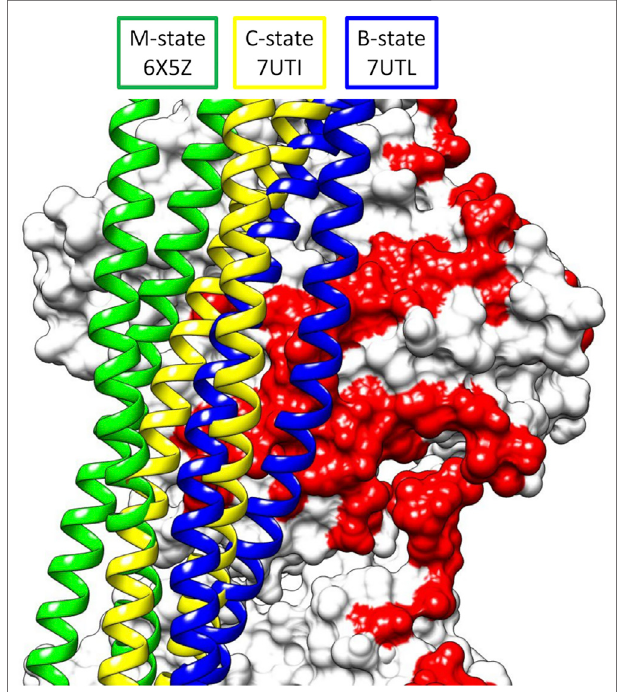
FIGURE 1 | Superposition of the three structural states of tropomyosin during thin fi lament activation of the M-state (green), C-state (yellow), and B-state (blue) showing the movement of tropomyosin over actin (white surface, pointed end up). Note the steric blocking of the myosin binding site (red) is relieved as tropomyosin moves from B- to M-state.